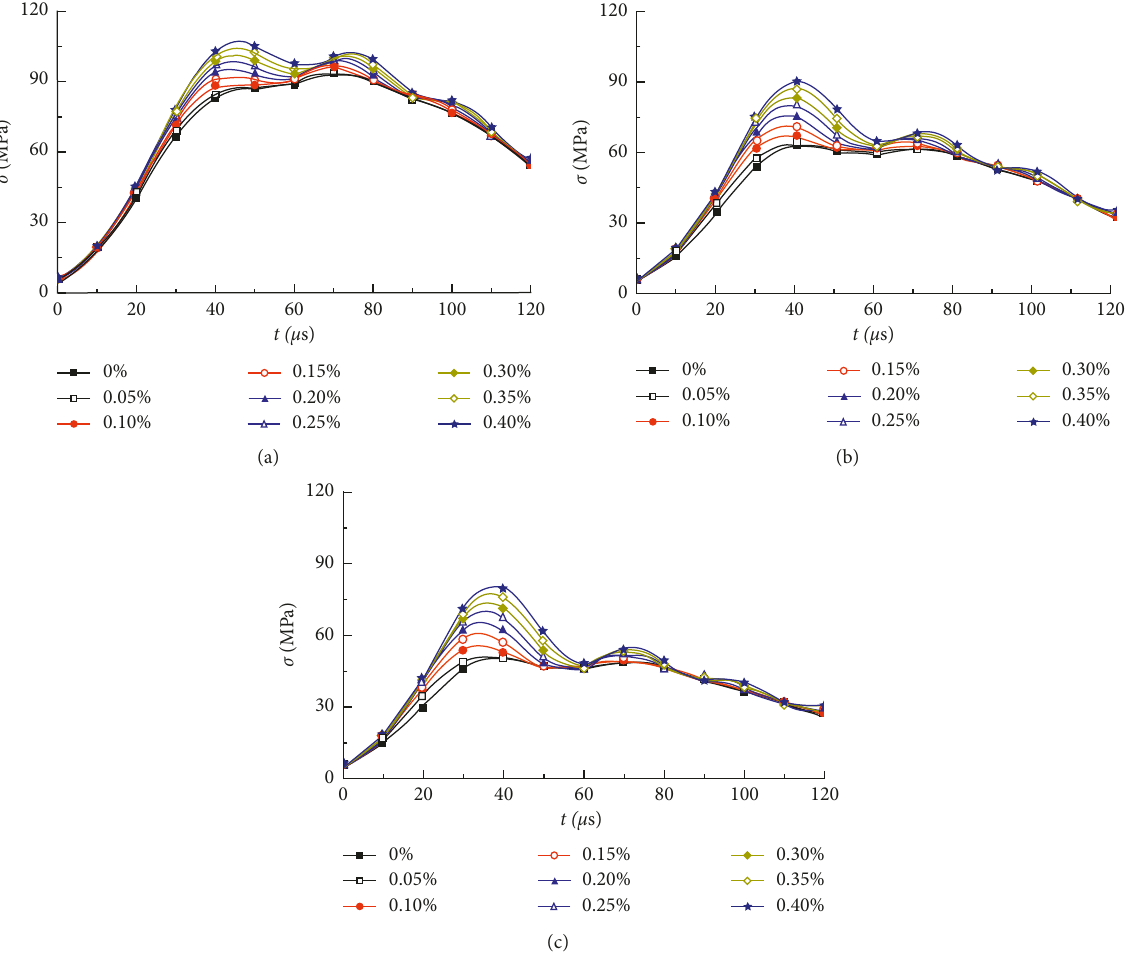
Figure 4: Reflected stresses of rock specimens for various end-surface nonparallelisms: (a) E